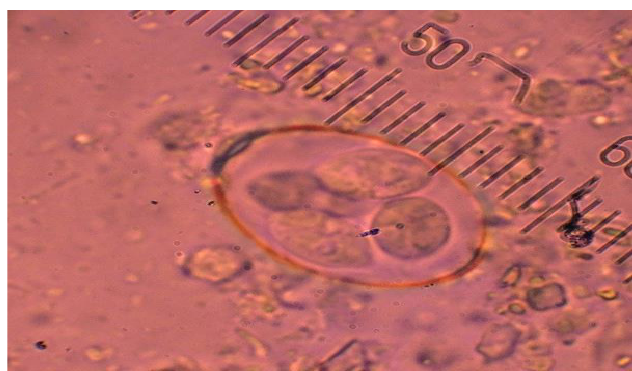
Figure 1. Non sporulated Eimeria intricata oocyst is seen using the method of floatation with Sheather's solution (40×)